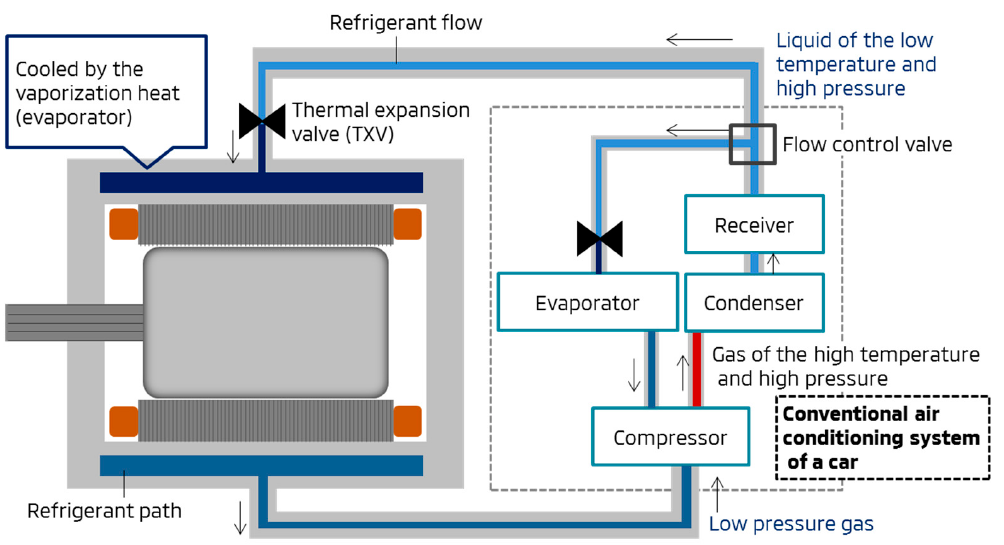
Figure 1. Proposed refrigerant cooling system.